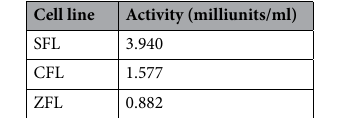
Table 1. The table shows the ALT activity levels of the cell